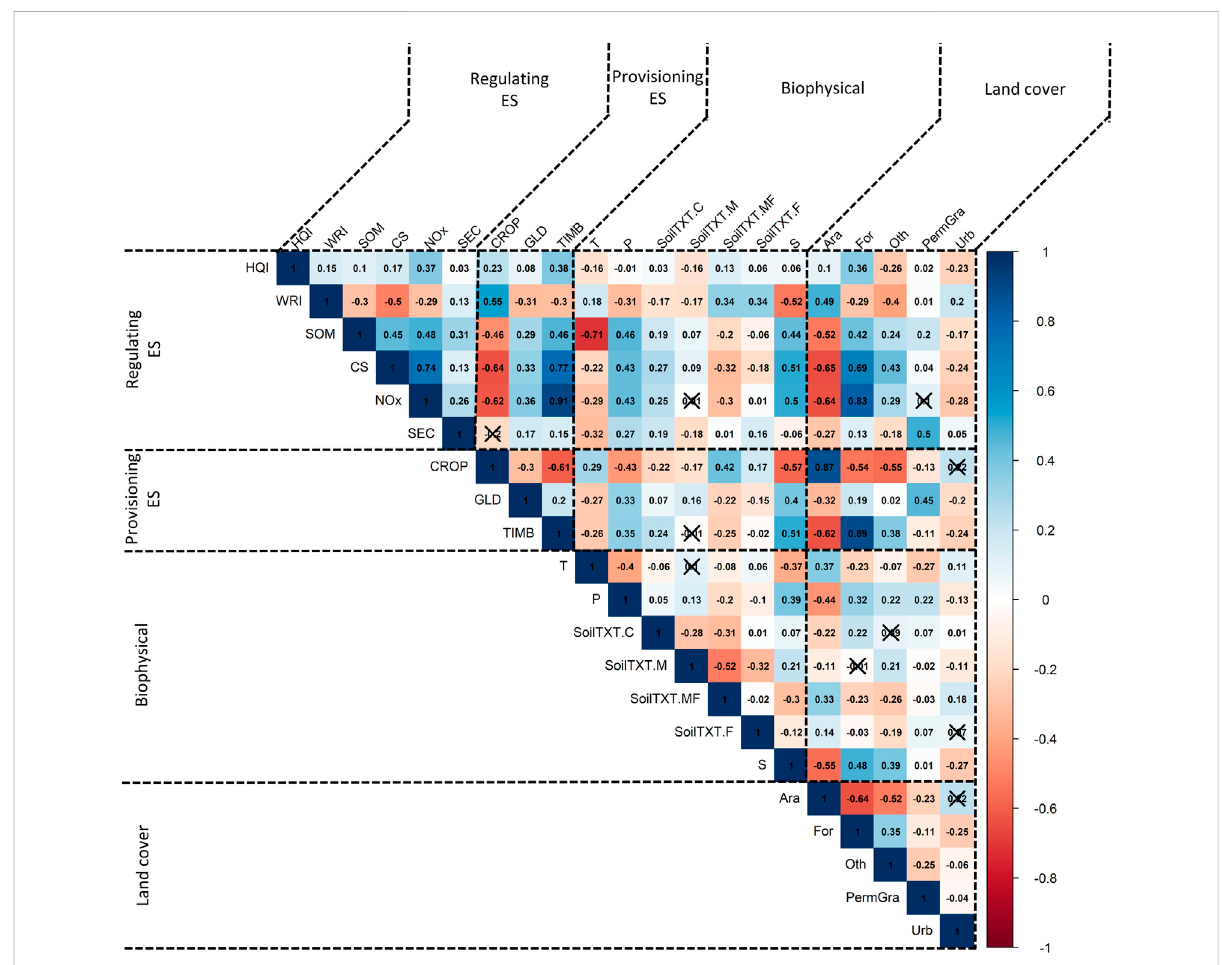
FIGURE 1 Correlation matrix between ecosystem services, biophysical variables, and land use area proportions at the scale of France using the Spearman method andwith asigni fi cancelevel of0.05. CROP stands forcrop production; CSfor carbon storage;HQI forhabitat qualityindex; GLDfor grazing livestock density; NOX for deposition velocity of nitrous oxide; SOM for topsoil organic matter concentration; SEC for soil erosion control; TIMB for timberremoval;WRIforwaterretentionindex;Sforslope;Tfortemperature;Pforprecipitation;Araforarableland;Forforest; O thforwetlands andwaterbodies;PermGraforpermanentgrassland;Urbforurbanareas;SoilTXT.Cfortheproportionoftheareawithcoarsesoiltexture;SoilTXT.M for the proportion of the area with medium soil texture; SoilTXT.MF for the proportion of the area with medium fi ne soil texture; SoilTXT.F for the proportion of the area with fi ne soil